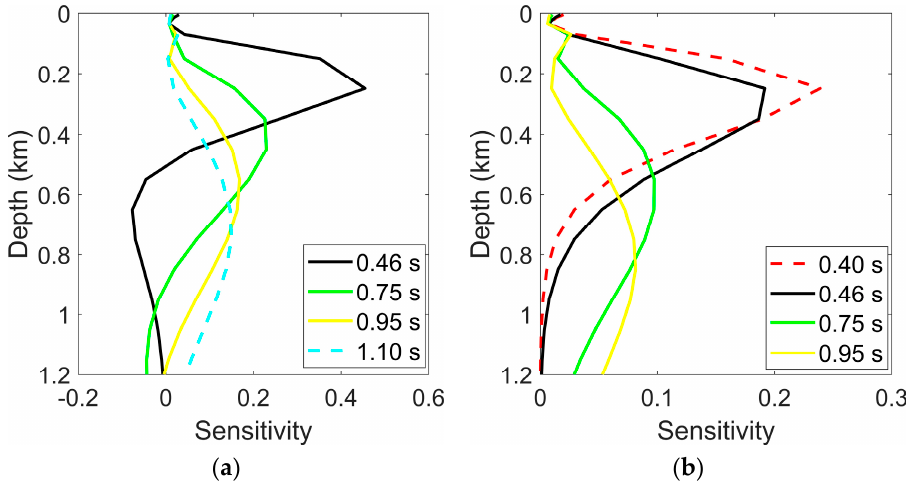
Figure 9. The depth sensitivity kernels for group ( a ) and phase ( b ) velocities at different periods. We assembled all the 1D Vs models at each grid point to construct the final 3D Vs model. Several representative horizontal slices were plotted in Figure 10, showing an ob- vious bimodal distribution of Vs in the area as observed in Rayleigh-wave group- and phase-velocity maps (Figure 7): high-velocity anomalies in the southwest and low-veloc- ity anomalies in the northeast. The fast anomalies mainly occur in the southwestern WLS, whereas the slow anomalies in the northeast generally correspond to the BSM and the West Lake region. The boundary separating the two anomalies lies to the NE of a NW–SE trending fault, suggesting that the fault dips towards NE. Furthermore, four velocity pro- files in Figure 11 traversing the main geological structures (Figure 2) were plotted to dis- play the lateral velocity variations. It is noticeable again that the boundary between the low-velocity structure in the northeast and the high-velocity structure in the southwest dips toward NE (AA’ and BB’ profiles). As shown in profiles AA’ and DD’, relatively thick low-velocity layers appear beneath the BSM.